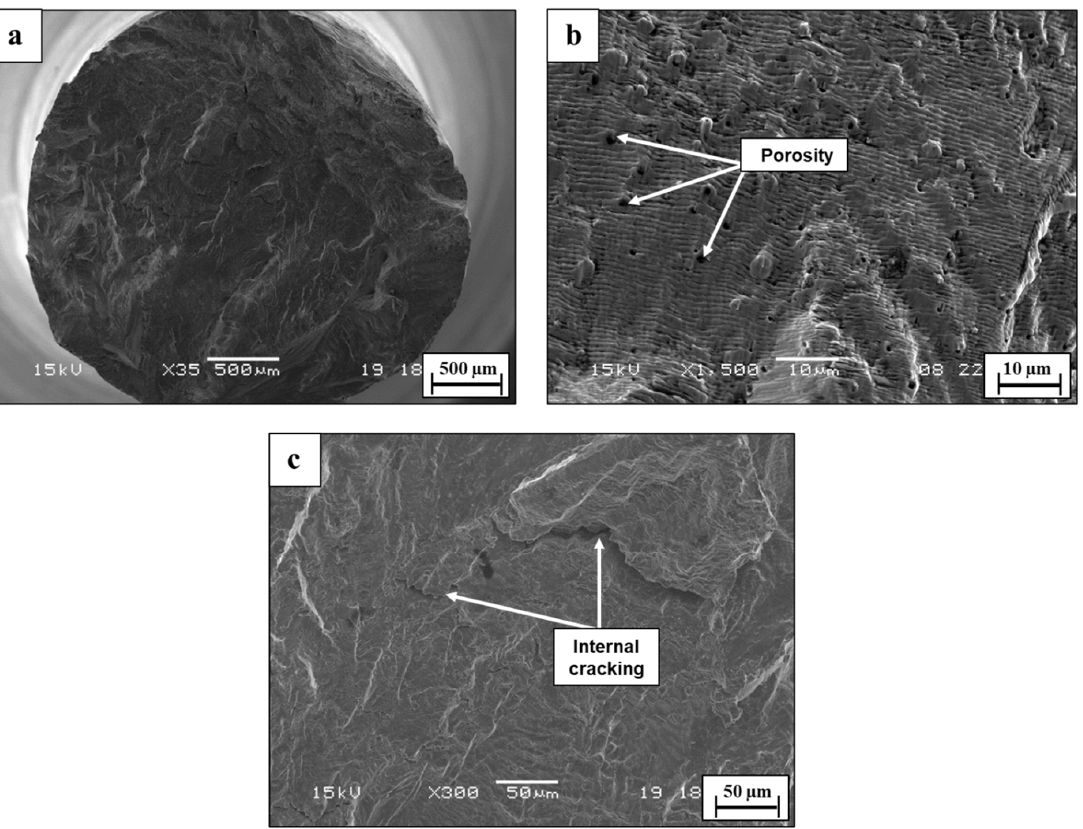
Figure 11. Fractography analysis of WLAM 316L alloy in air (S = 290 MPa, N = 245,700). ( a ) General view ( b , c ) close-up view.